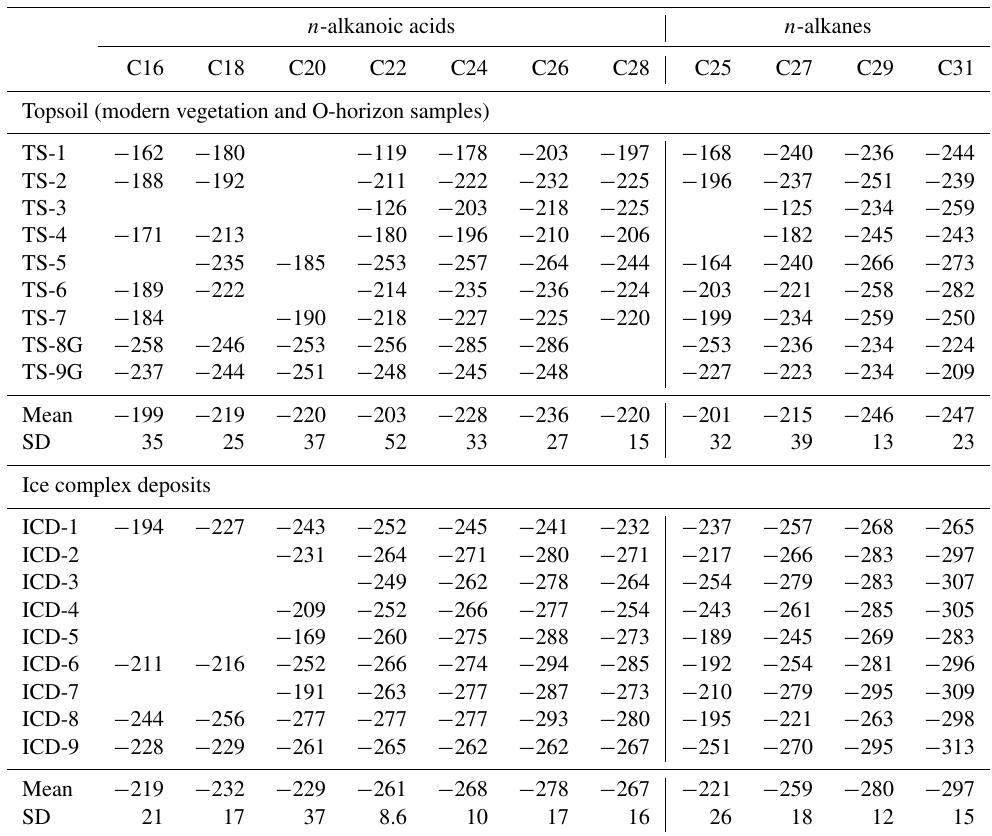
Table 5. δ 2 H signatures (in ‰) of n -alkanoic acids and n -alkanes of topsoil Holocene (modern vegetation and O horizon) and Pleistocene ice complex